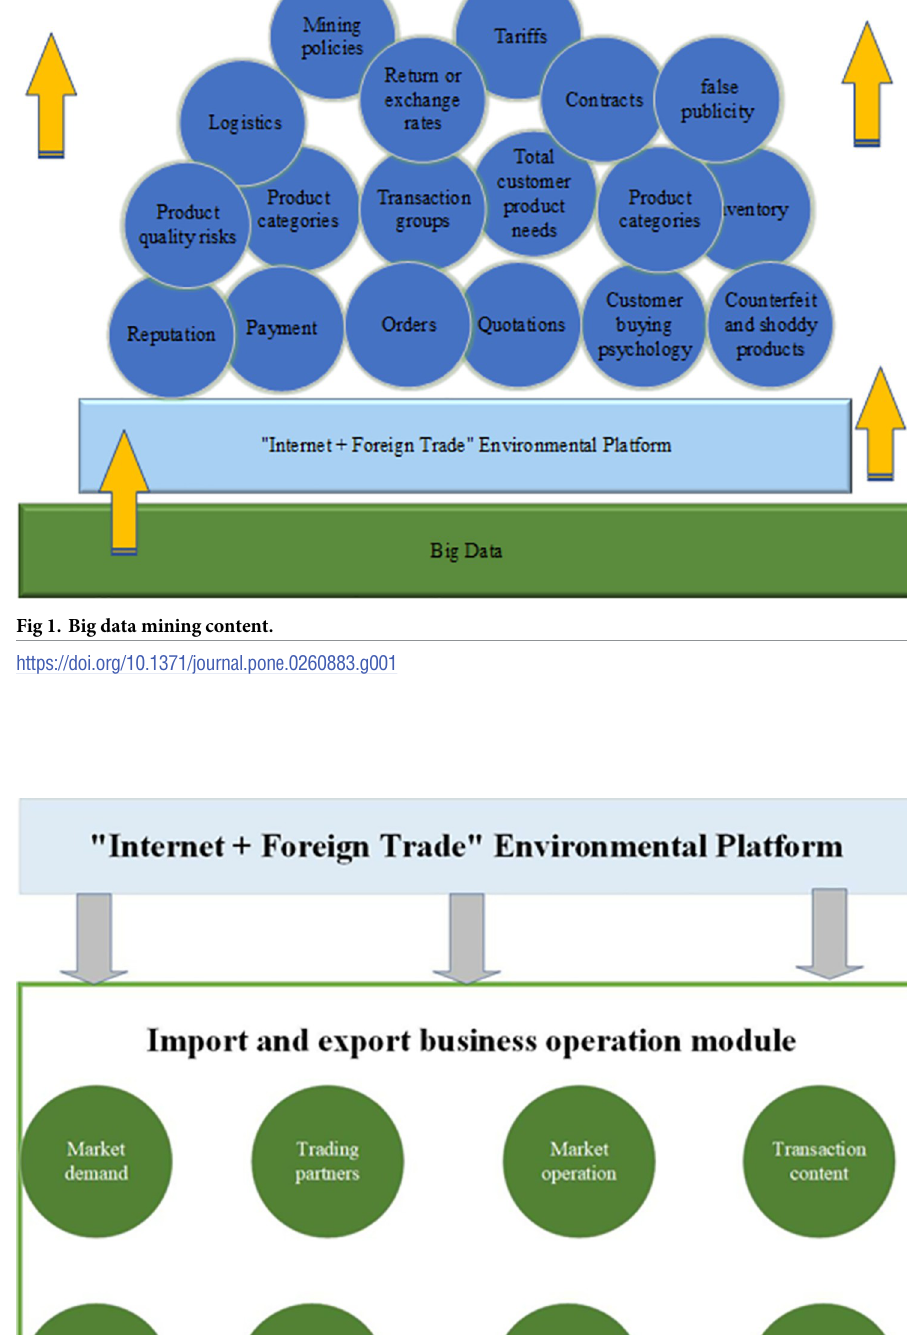
PLOS ONE | https://doi.org/10.1371/journal.pone.0260883 December3,